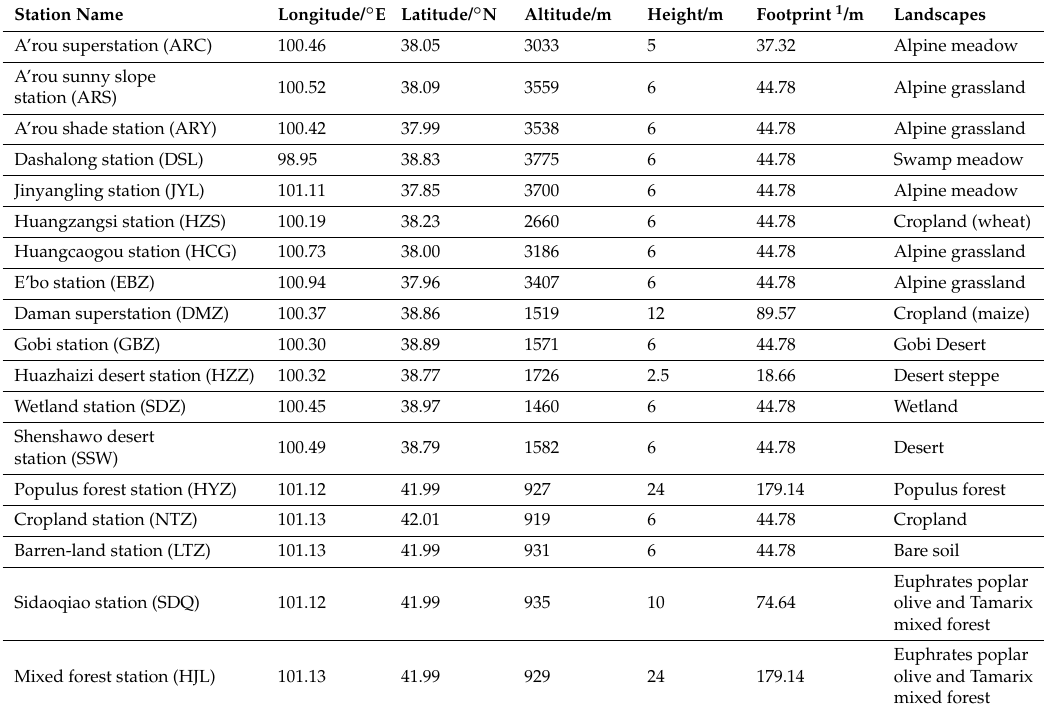
Figure 2. Study area and locations of the validation stations. Table 1. Information for the stations in this study.